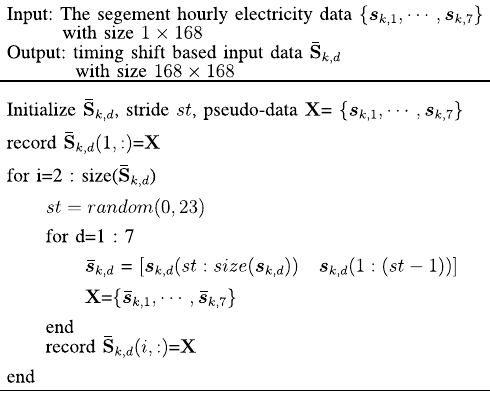
Table 2 Timing shift algorithm